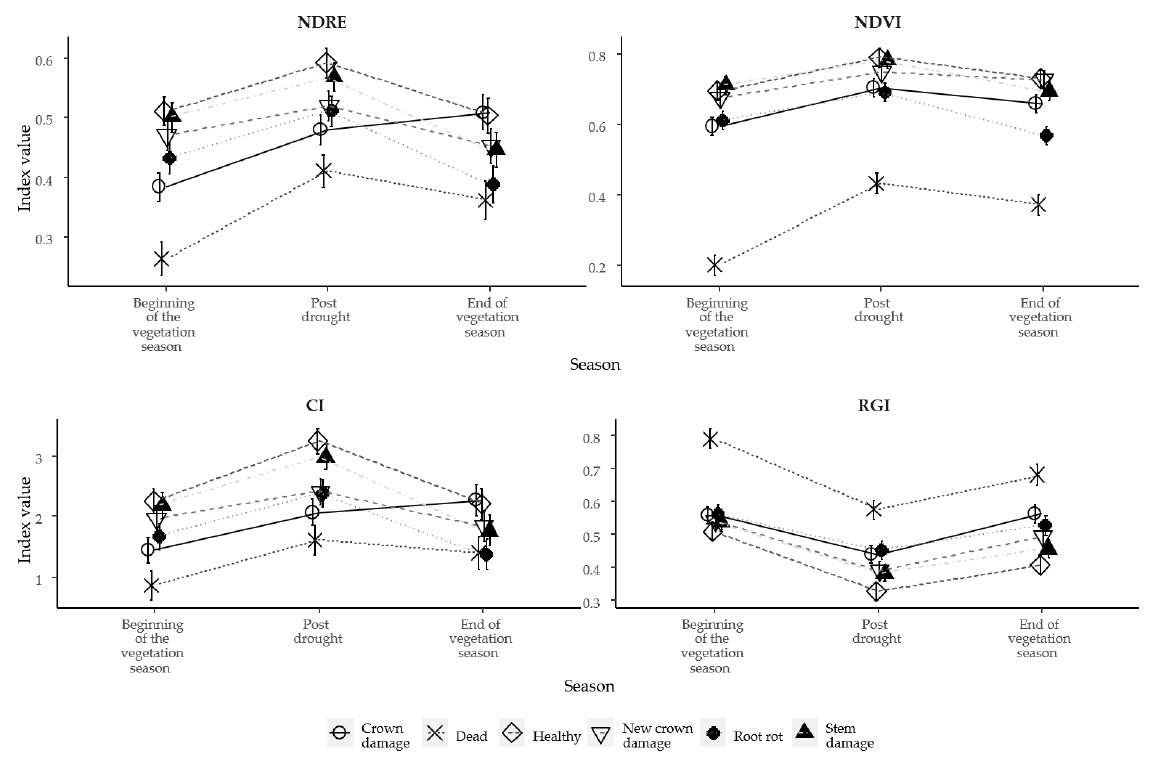
Figure 4. The mean values of selected vegetation indices and tree health classes over vegetation season.